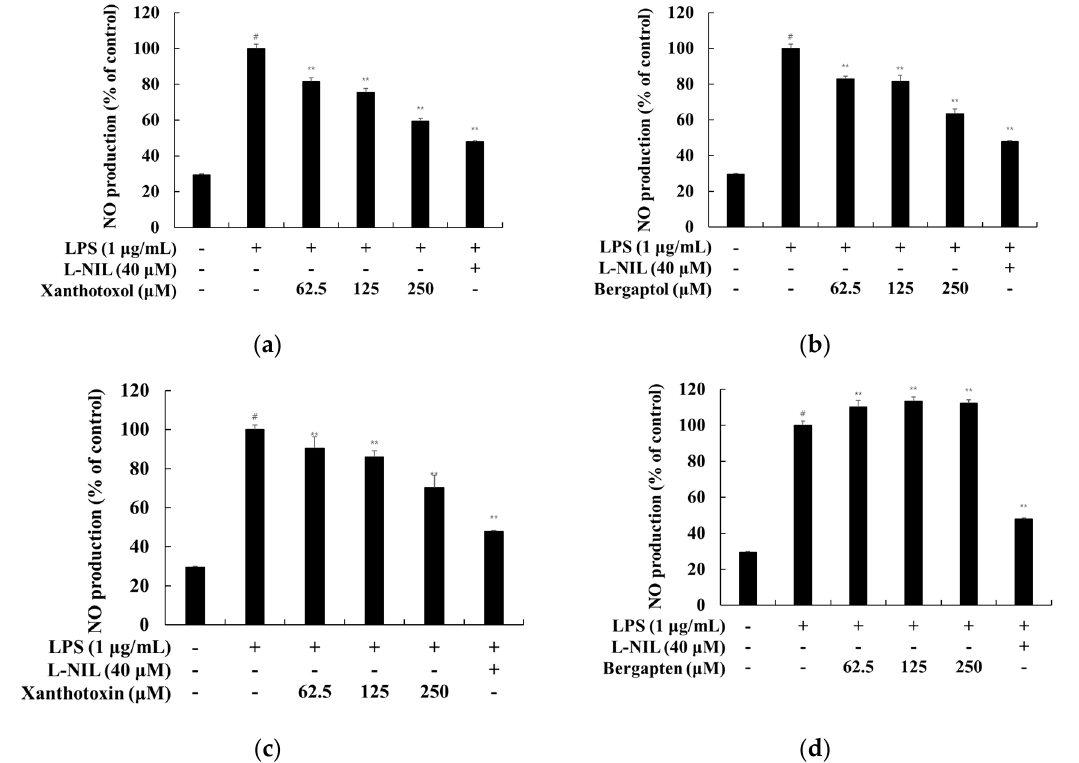
Figure 3. Effect of psoralen derivatives on nitric oxide production in LPS-induced RAW 264.7 cells. The cells were treated with psoralen derivatives (62.5, 125, and 250 μ M) and L-NIL (40 μ M) for 24 h with LPS (1 μ g/mL). L-NIL was used as a positive control. NO production of LPS-induced RAW 264.7 cells subjected to ( a ) 8-hydroxypsoralen (xanthotoxol), ( b ) 5-hydroxypsoralen (bergaptol), ( c ) 8-methoxypsoralen (xanthotoxin), and ( d ) 5-methoxypsoralen (bergapten) treatment were measured using Griess reagents. The results are presented as the mean ± SD from three independent experiments. # p < 0.01 vs. untreated control group. * p < 0.05 and ** p < 0.01 vs. LPS alone.